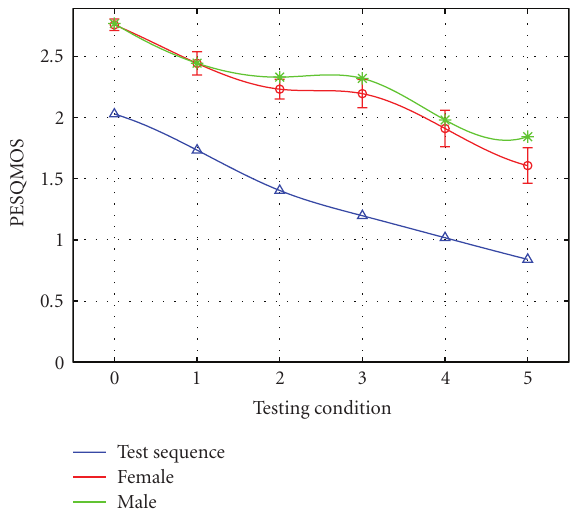
Figure 10: Impact of background tra ffi c on speech quality of speech sequences and test sequence. Other detailed descriptions of Figure 7 apply appropriately.